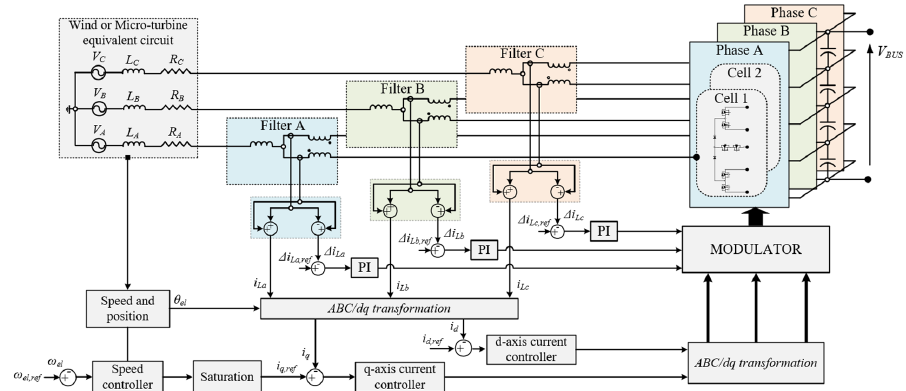
Figure 11. Block diagram of the 3 Φ 5L E-Type MMR control algorithm for wind or micro-turbine sources.